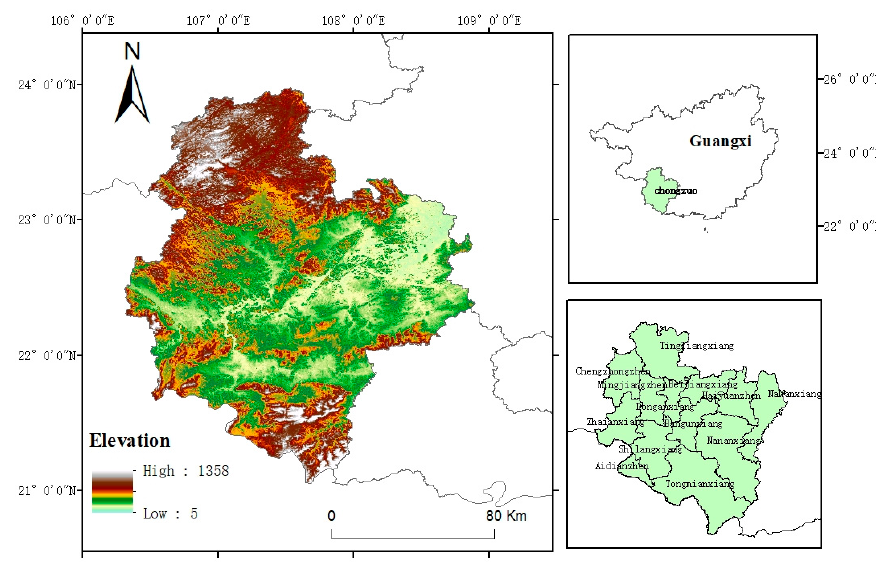
Figure 1. Distribution map of study area.